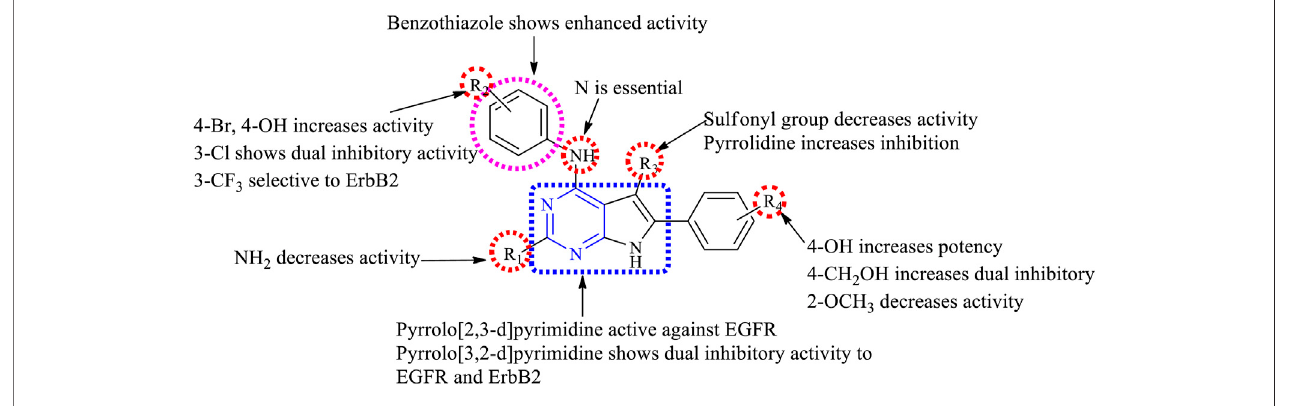
FIGURE 9 | Summary SAR of disubstituted